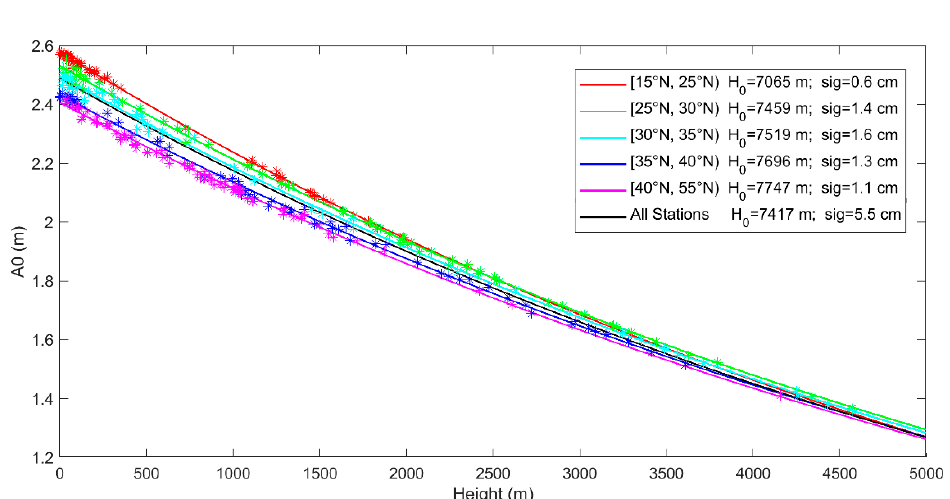
Figure 4. Annual average ZTD w.r.t. site ellipsoidal height and the exponential fitting curves. The scaled height and the fit RMS are also presented in the figure.